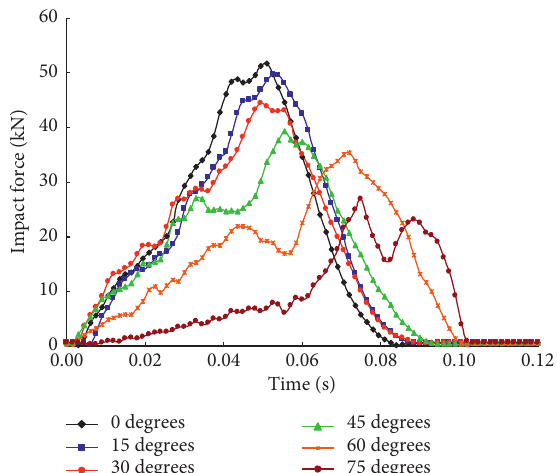
Figure 10: The time-domain responses of impact of rock fall under different impact angles.